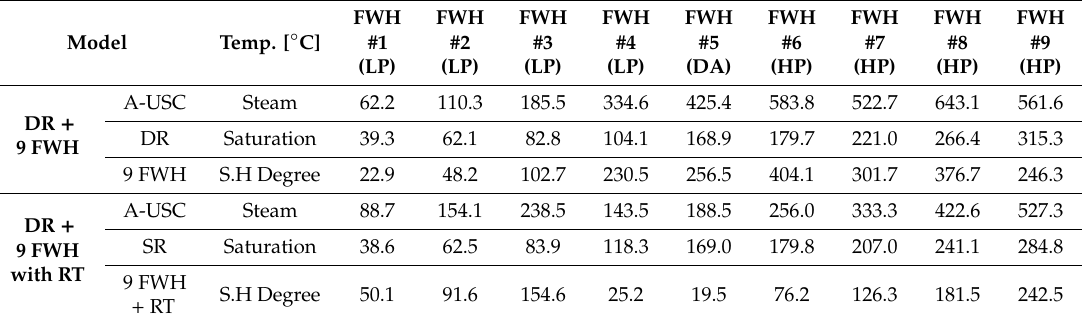
Table 8. Comparison of overheating of USC & A-USC with